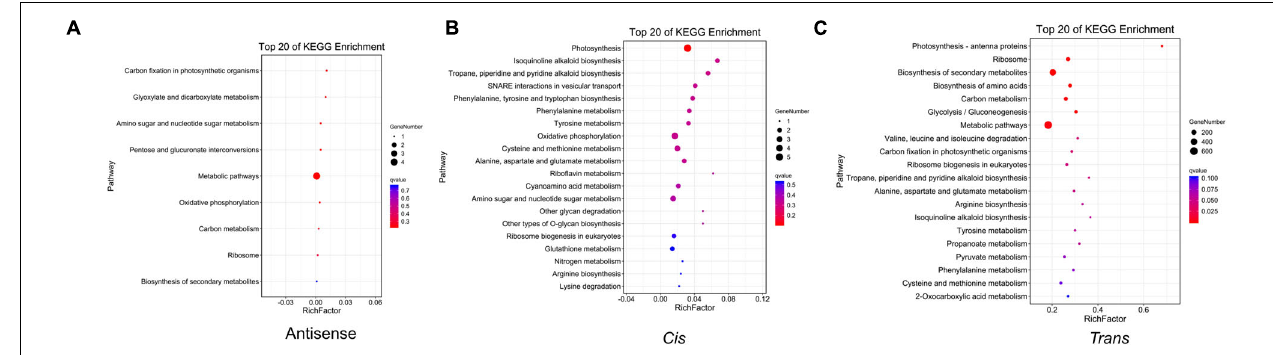
FIGURE 5 | The KEGG pathway analysis of the target genes of DElncRNAs. (A) The KEGG pathway analysis of the antisense-targeted genes of DElncRNAs. (B) The KEGG pathway analysis of cis -targeted genes of DElncRNAs. (C) The KEGG pathway analysis of trans -targeted genes of DElncRNAs.